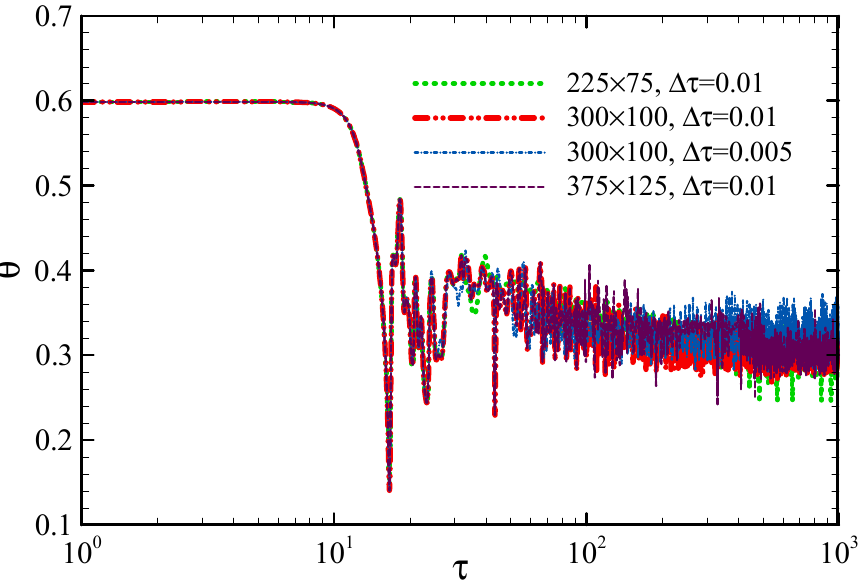
Figure 2. Temperature time series at P 2 (0, 0.4) for Ra = 10 8 with distinct grids and timesteps. Table 1. Temperature at P 2 (0, 0.4) employing various grids and timesteps. Grids and Time Steps Average Value of the Temperature Percentage of the Variance 225 × 75 and ∆ τ = 0.01 300 × 100 and ∆ τ = 0.01 300 × 100 and ∆ τ = 0.005 375 × 125 and ∆ τ = 0.01